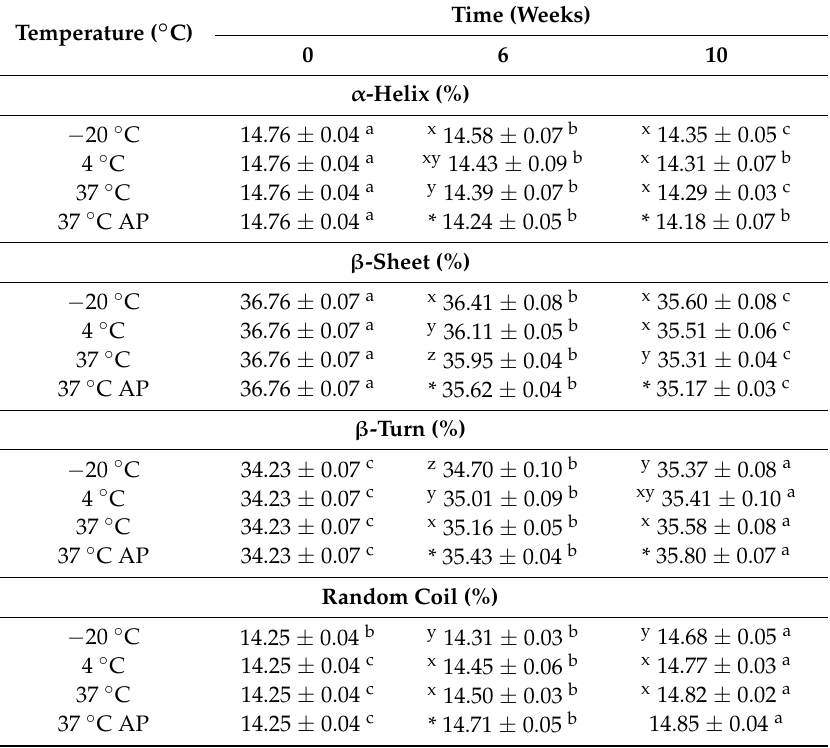
Table 1. Secondary structure compositions of PPI under different temperatures and packaging methods.